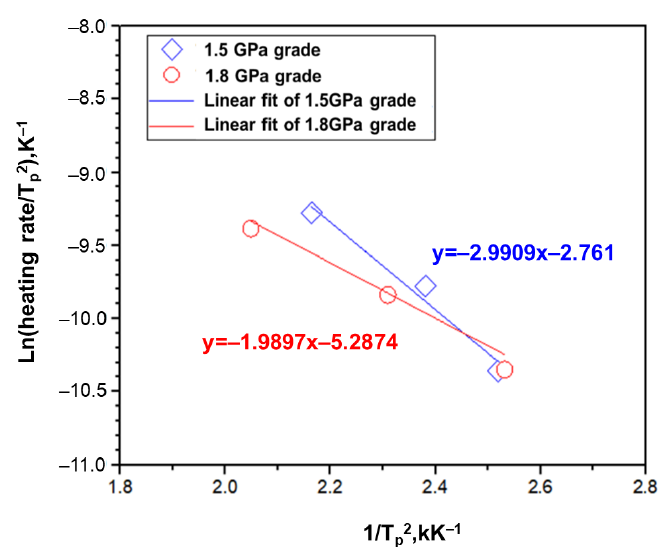
Figure 7. The fitting graph from the TDS results depending on the different heating rates on the 1.5 GPa grade and 1.8 GPa grade alloys. Table 6. Activation energy of diffusible hydrogen under 573 K in the studied alloys.